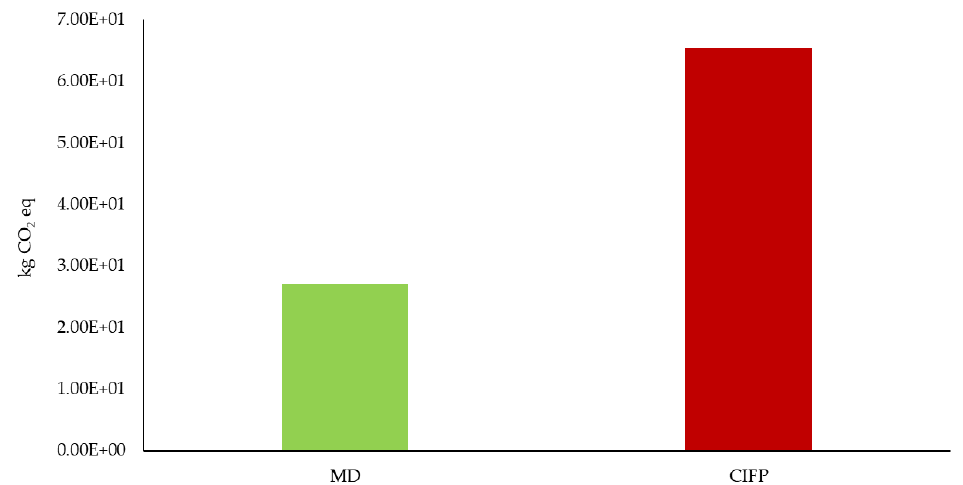
Figure 5. Carbon footprint of Mediterranean diet and Italian dietary habits (MD: Mediterranean diet; CIFP: Current Italian food patterns).